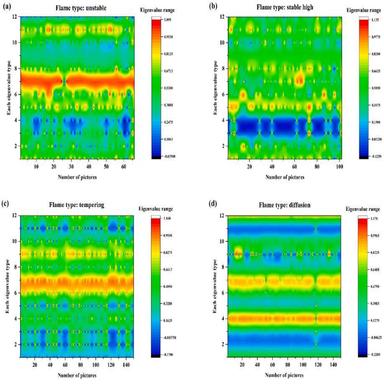
Composite of eigenvalues of different flame types. (a) Unstable; (b) Stable; (c) Tempering; (d) Diffusion.